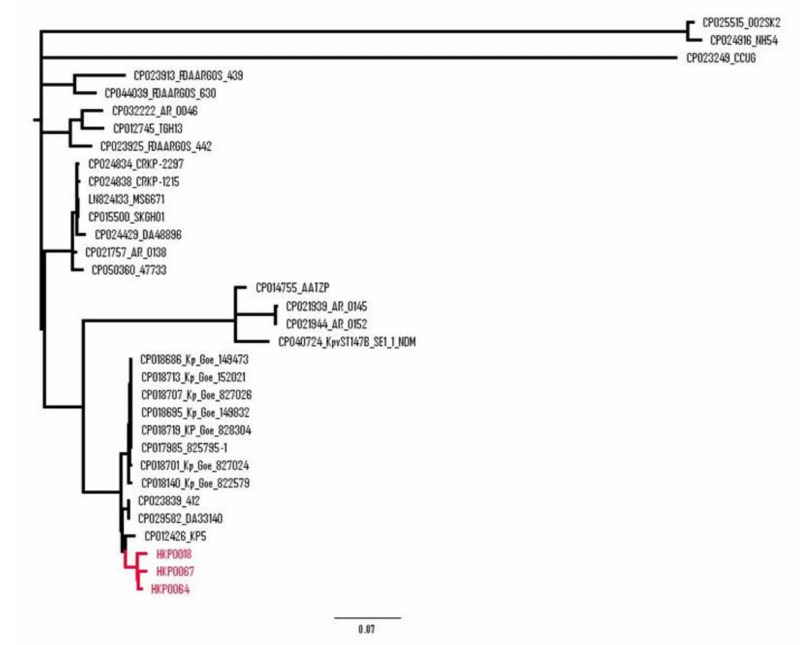
Figure 1. Phylogenetic analysis of HKP0018, HKP0064, HKP0067 and 30 ST147 K. pneumoniae isolates. Phylogenetic maximum-likelihood tree was generated using the FigTree v1.4.3 software of the SNP analysis performed using the kSNP3 tool (Galaxy version 3.1) software at the ARIES Galaxy server (https: // aries.iss.it /